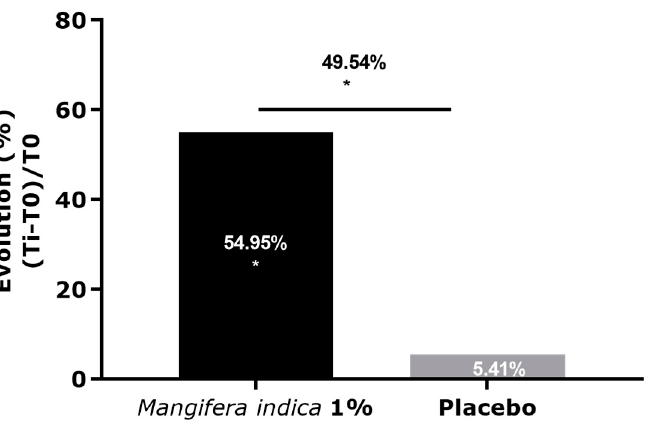
Figure 6. Analysis of TG/FFA ratio by GC LC/MS extracted from sebum of Caucasian volunteers after 28 days of application of cream containing M. indica extract at 1% or placebo. Significance with * p < 0.05.